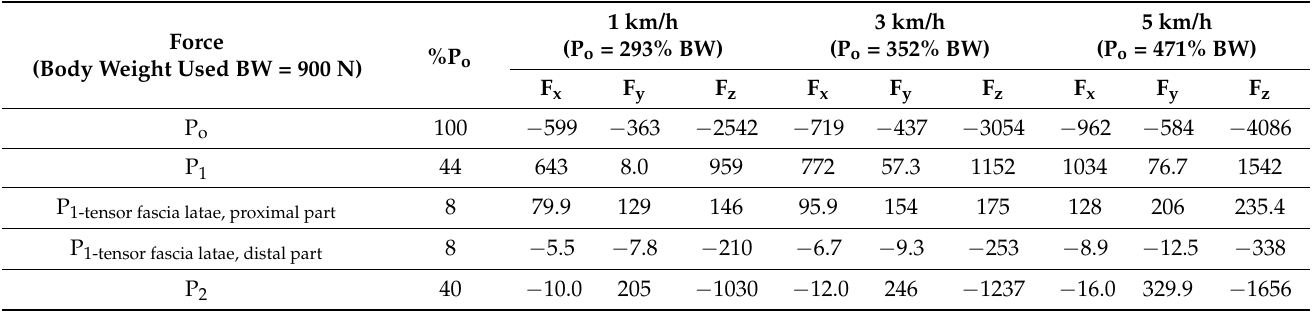
Figure 4. Finite element analysis of dense and porous Ti stems according to the ISO 7206-4 standard. Table 3. Body weight and muscular loads for different walking speeds [39,40] (with reference to Bergmann et al., 1993, Heller et al.,